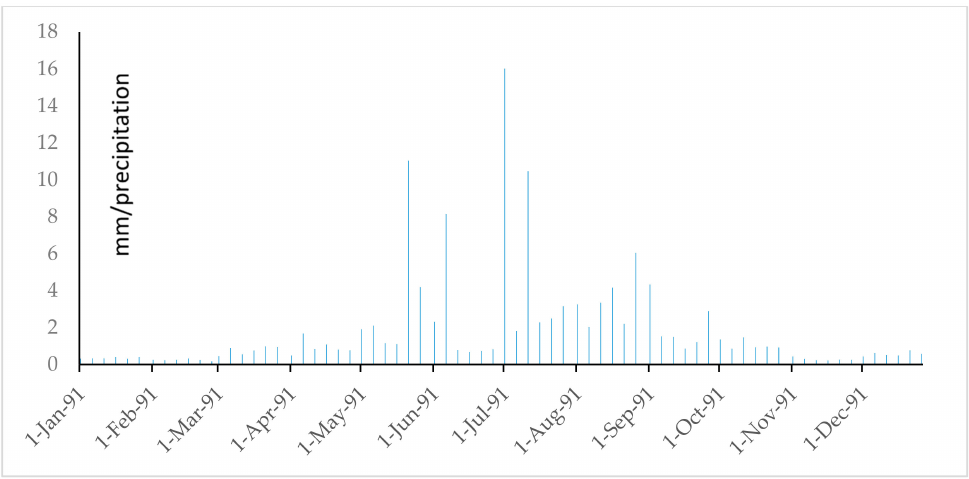
Figure A19. Precipitation of Denko County in 1991.